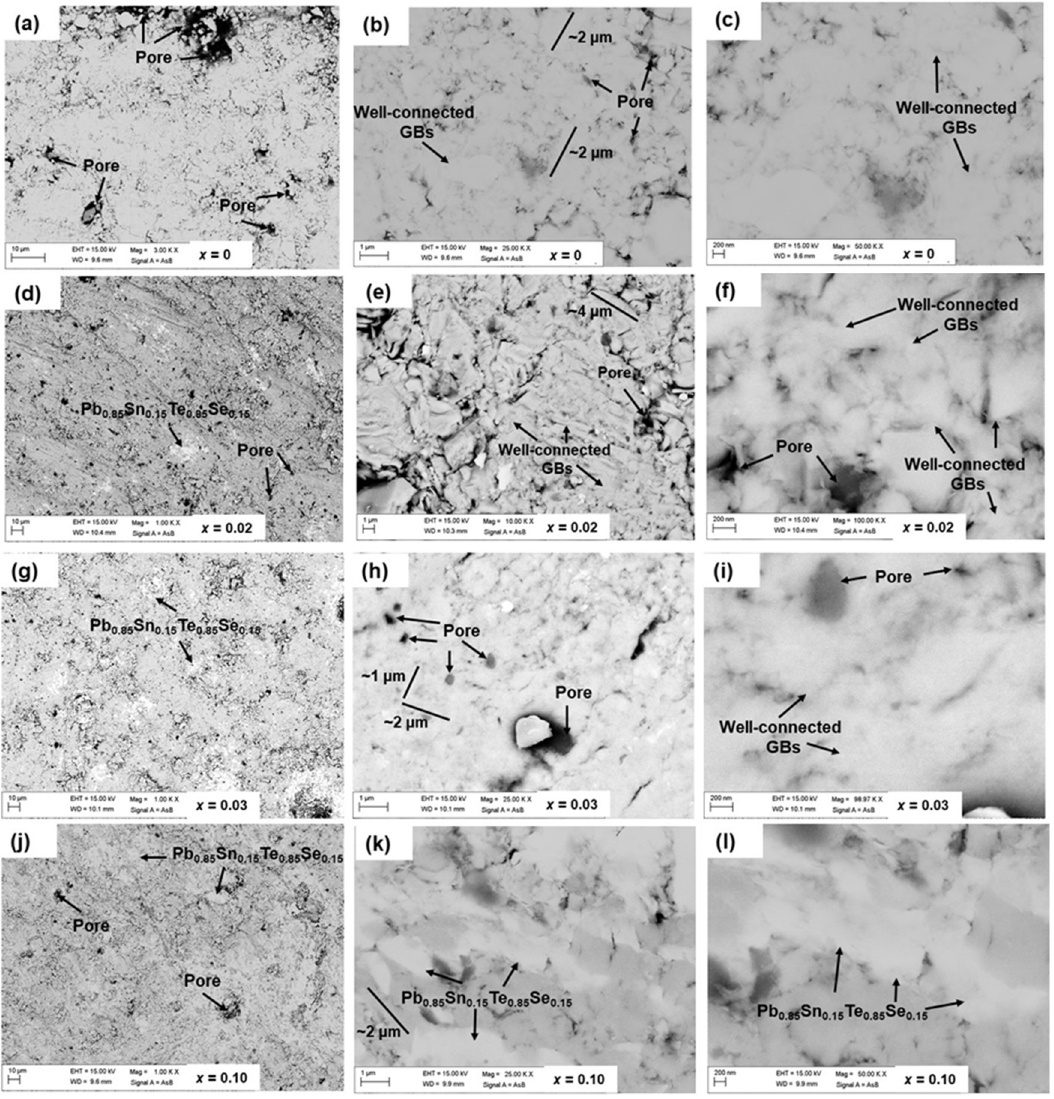
Figure 2. Back-scattered (BSE) images of various Pb and Sn-added FeSe 0.5 Te 0.5 + x Pb + y Sn polycrys- talline samples: ( a – c ) for x = y = 0; ( d – f ) for x = y = 0.02; ( g – i ) for x = y = 0.03 and ( j – l ) for x = y = 0.10. Bright contrast, light grey, and black contrast correspond to the phase of Pb 0.85 Sn 0.15 Te 0.85 Se 0.15 , Fe(Se, Te) and pores, respectively. The approximate grain size is depicted by the solid line.